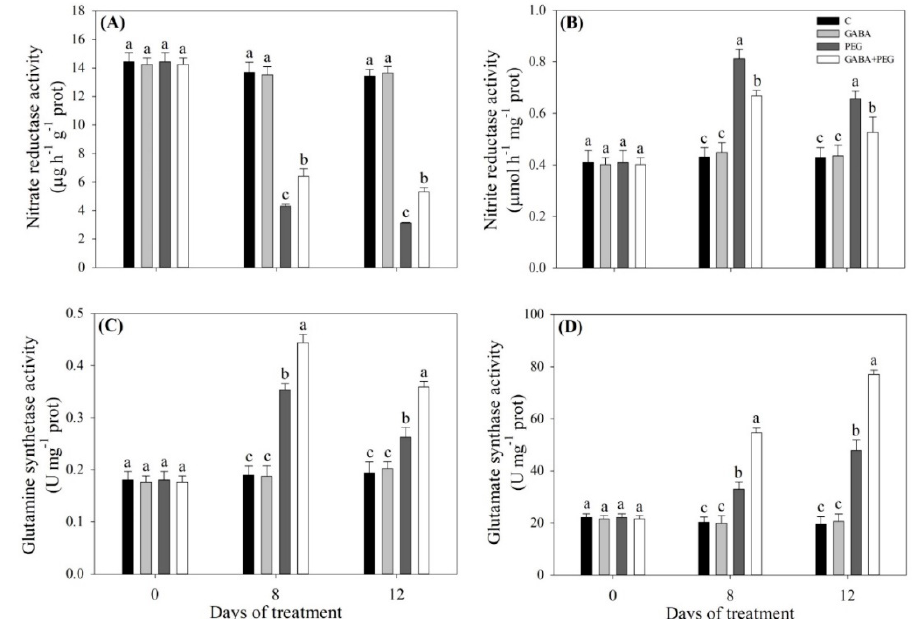
Figure 6. E ff ects of exogenous γ -aminobutyric acid (GABA) pretreatment on ( A ) nitrate reductase activity, ( B ) nitrite reductase activity, ( C ) glutamine synthetase activity, and ( D ) glutamate synthase activity in leaves of creeping bentgrass under non-stress and water stress conditions. Vertical bars indicate ± SE of mean ( n = 4). Di ff erent letters above columns indicate significant di ff erence at a particular day based on the LSD ( P ≤ 0.05). C, well-watered control; GABA, well-watered control pretreated with GABA; PEG, PEG-induced water stress; GABA + PEG, water-stressed plants pretreated with